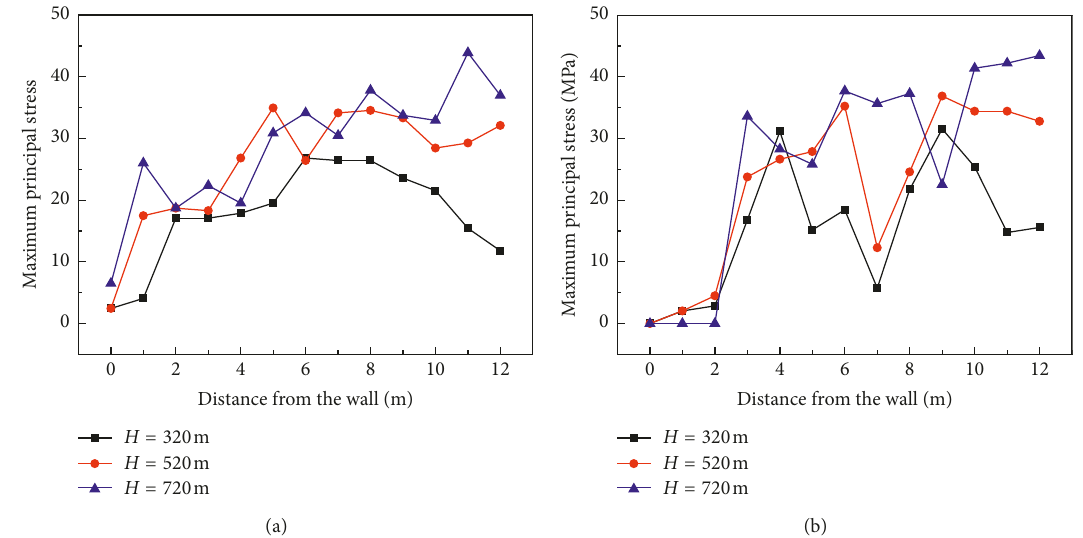
Figure 6: Maximum principal stress of (a) top coal and (b) lower coal with 1.5 m thick medium-strength hard coal gangue at different depths.